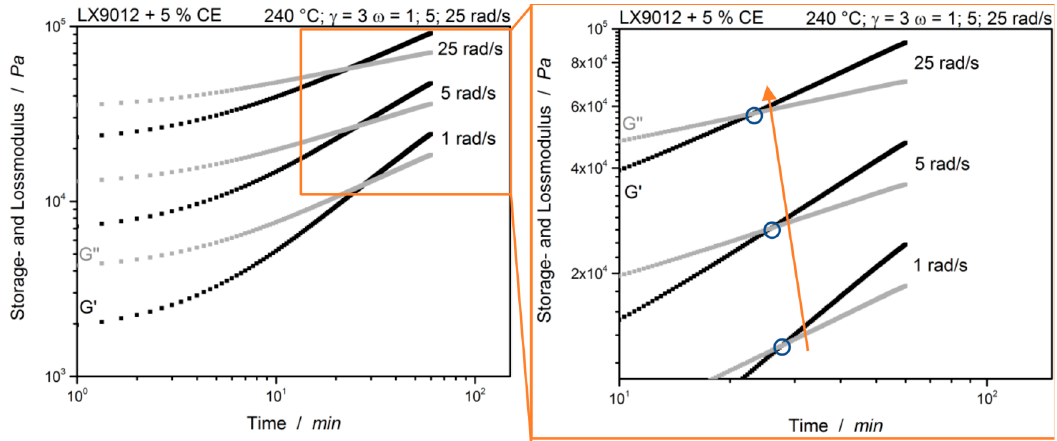
Figure 8. Time Sweeps of LX9012 with 5% chain extender measured at 240 °C with multiwave test. Gel-point is highlighted.